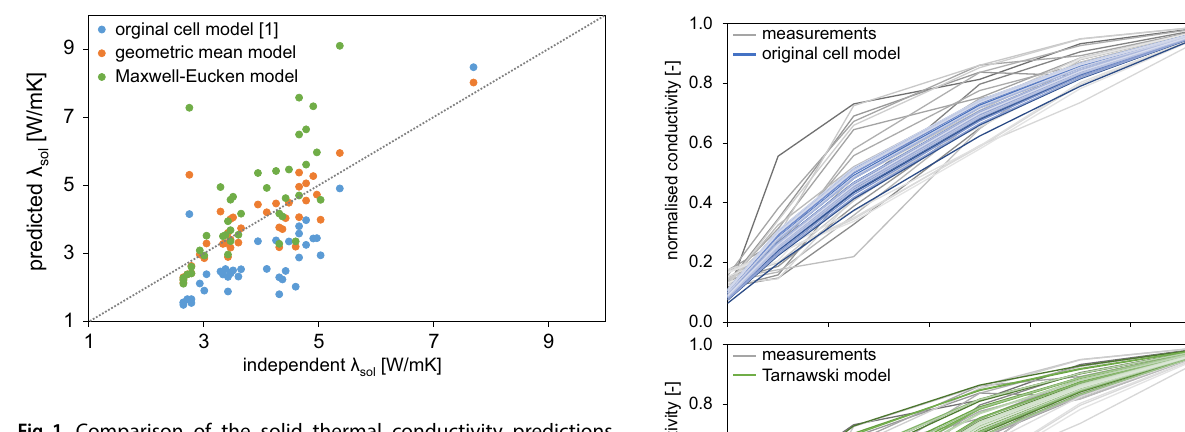
Fig. 1 Comparison of the solid thermal conductivity predictions by the original cell model, geometric mean model and Maxwell- Eucken model (see Sect. 4 for the relevant discussion of the latter), versus an independent estimate described in Eq. 3 here